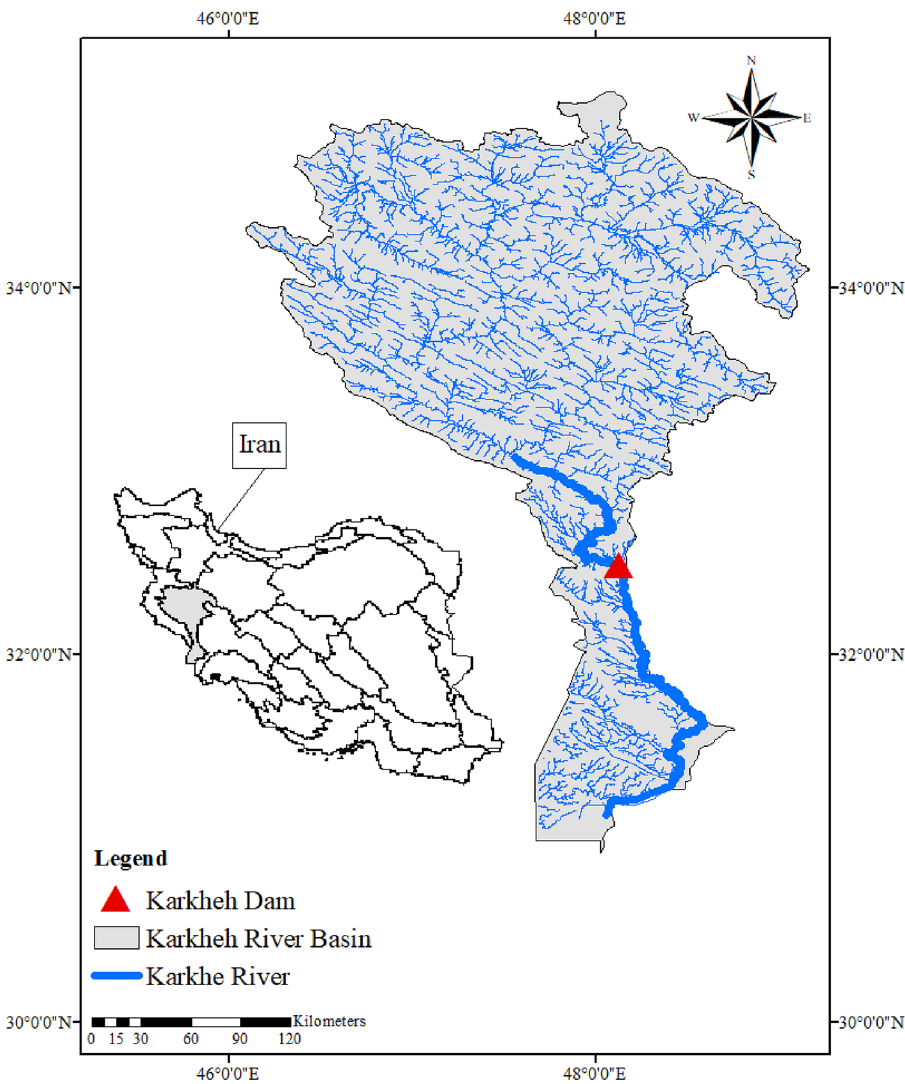
Figure 4. Study area and the location of Karkheh Dam. (ArcGIS 10.7.1, https:// www. esri. com/ en- us/ arcgis/ produ cts/ arcgis- pro/ overv